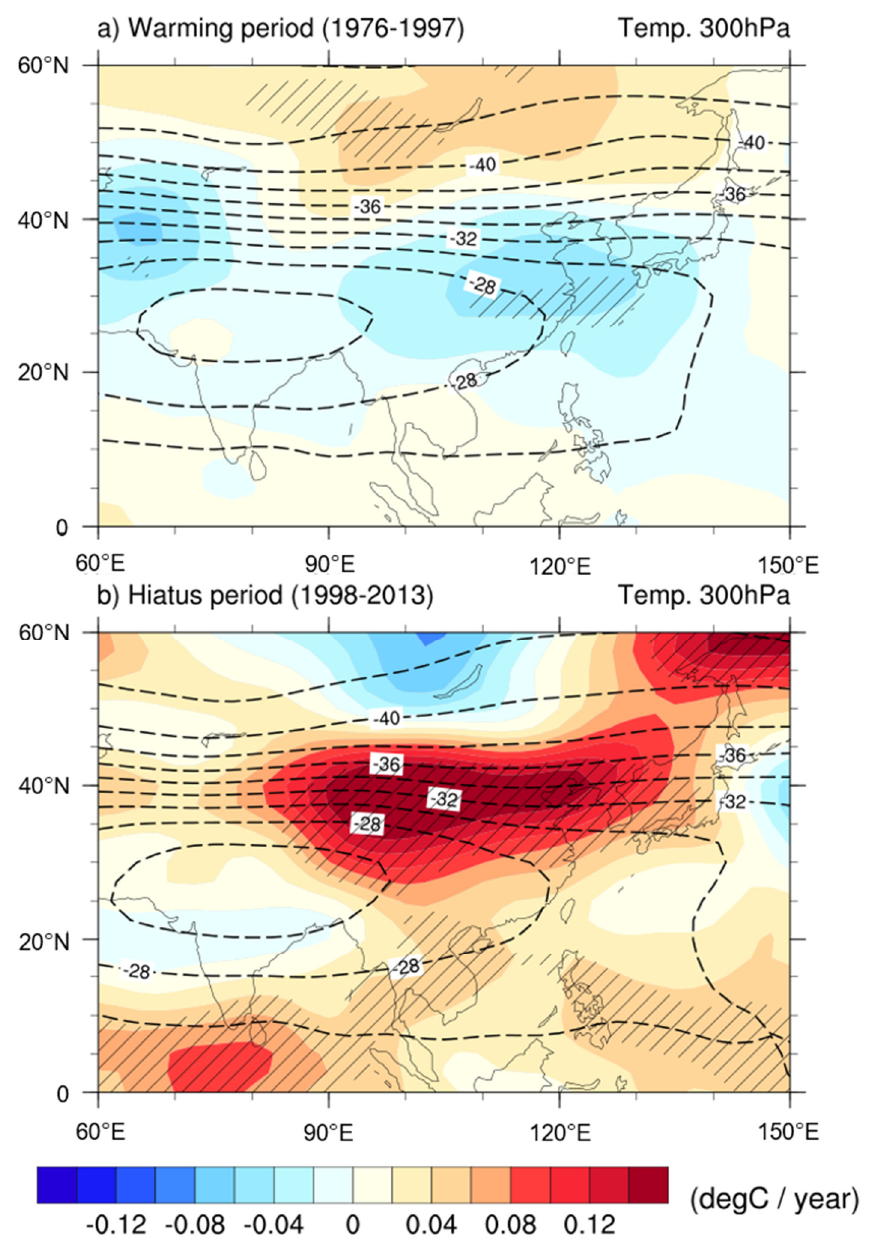
Figure 6. Same as Figure 3, but for